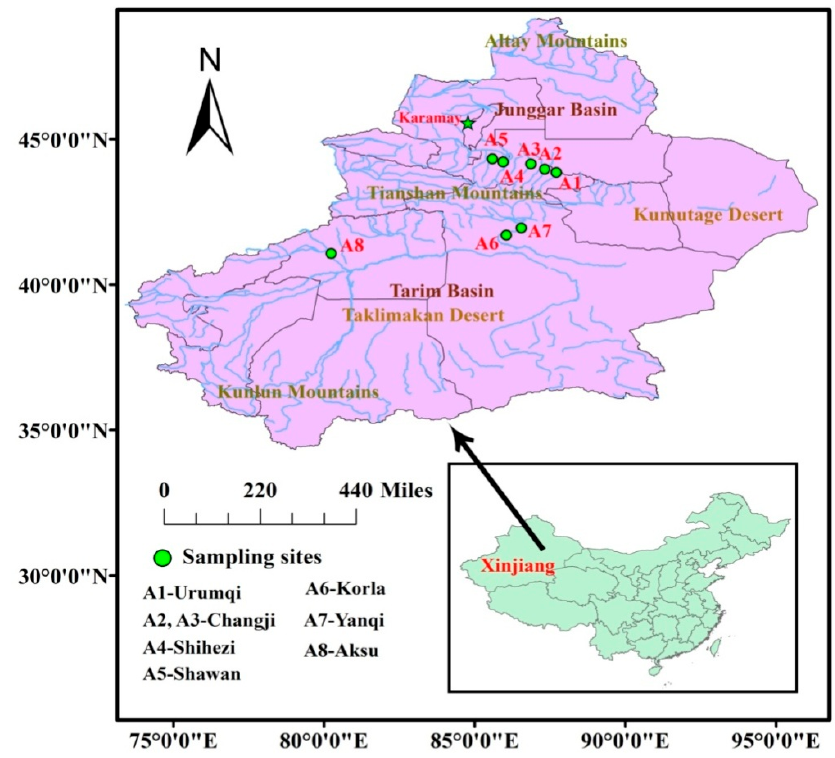
Figure 1. Sampling locations in Xinjiang.